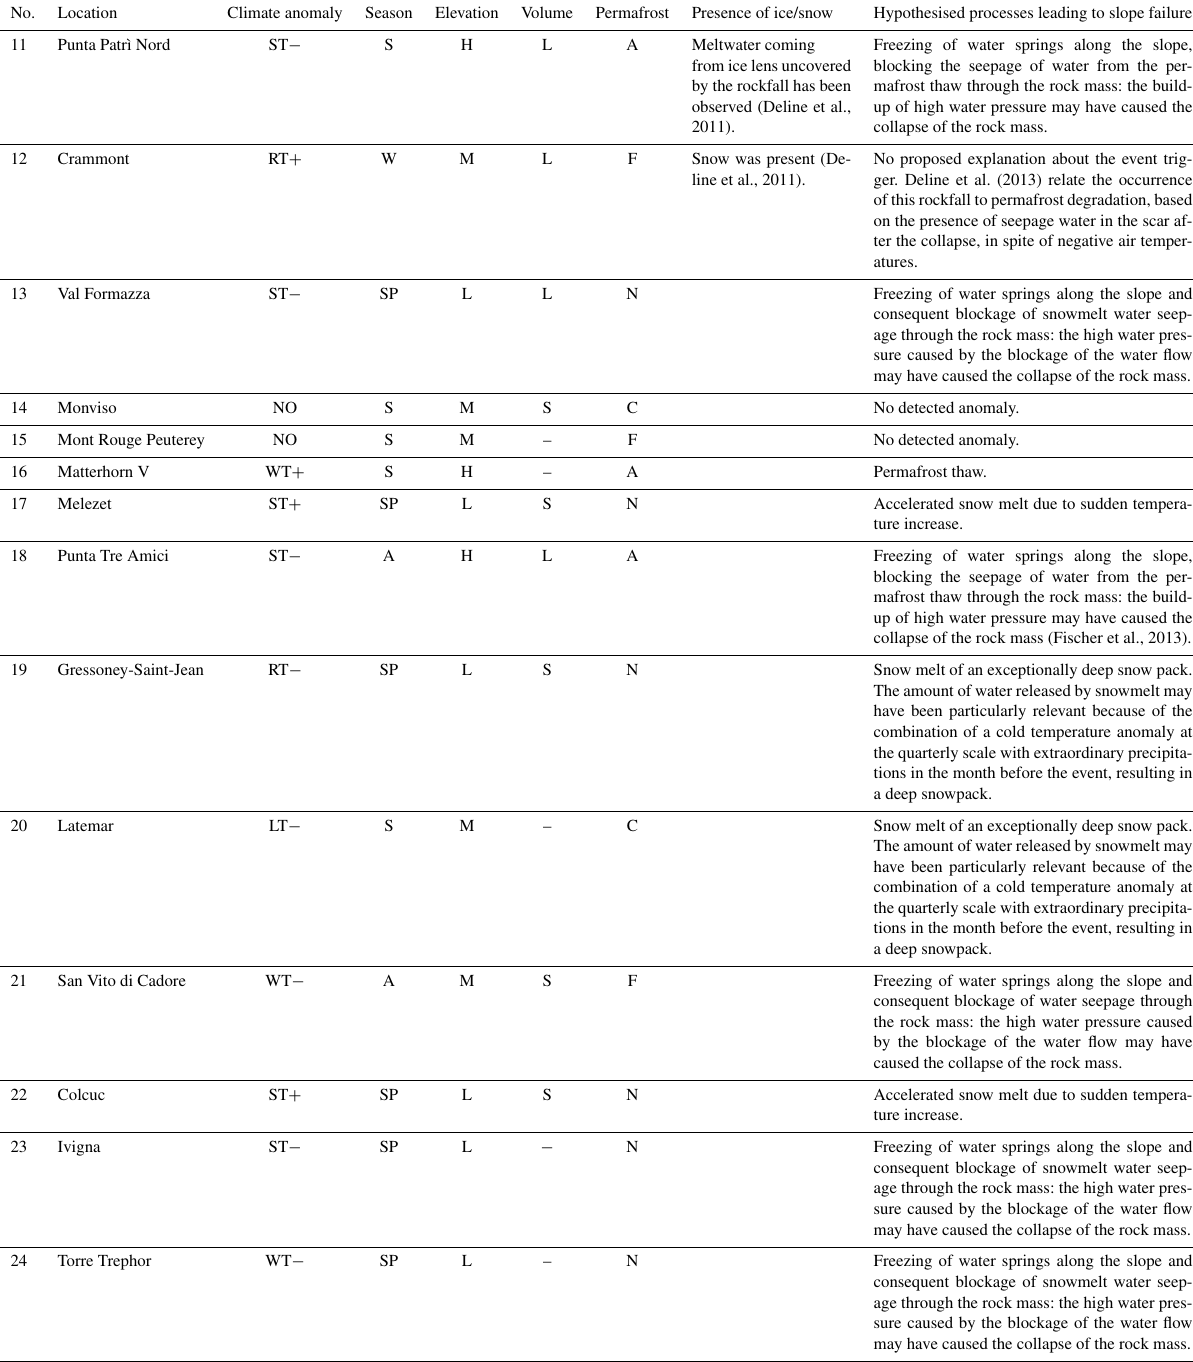
Climate anomaly Season Elevation Volume Permafrost Presence of ice/snow Hypothesised processes leading to slope failure Punta Patrì Nord Meltwater coming fromicelensuncovered